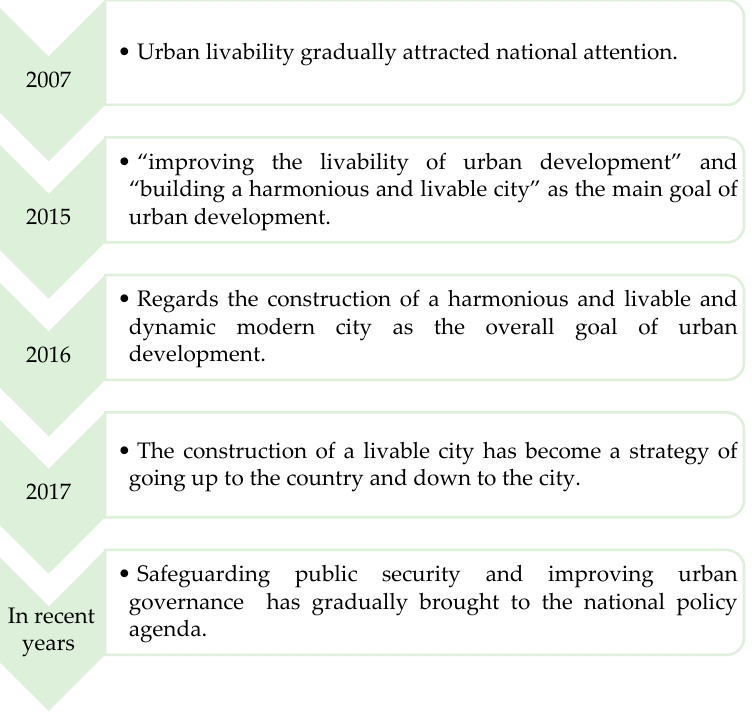
Figure 2. Development of livability in China.